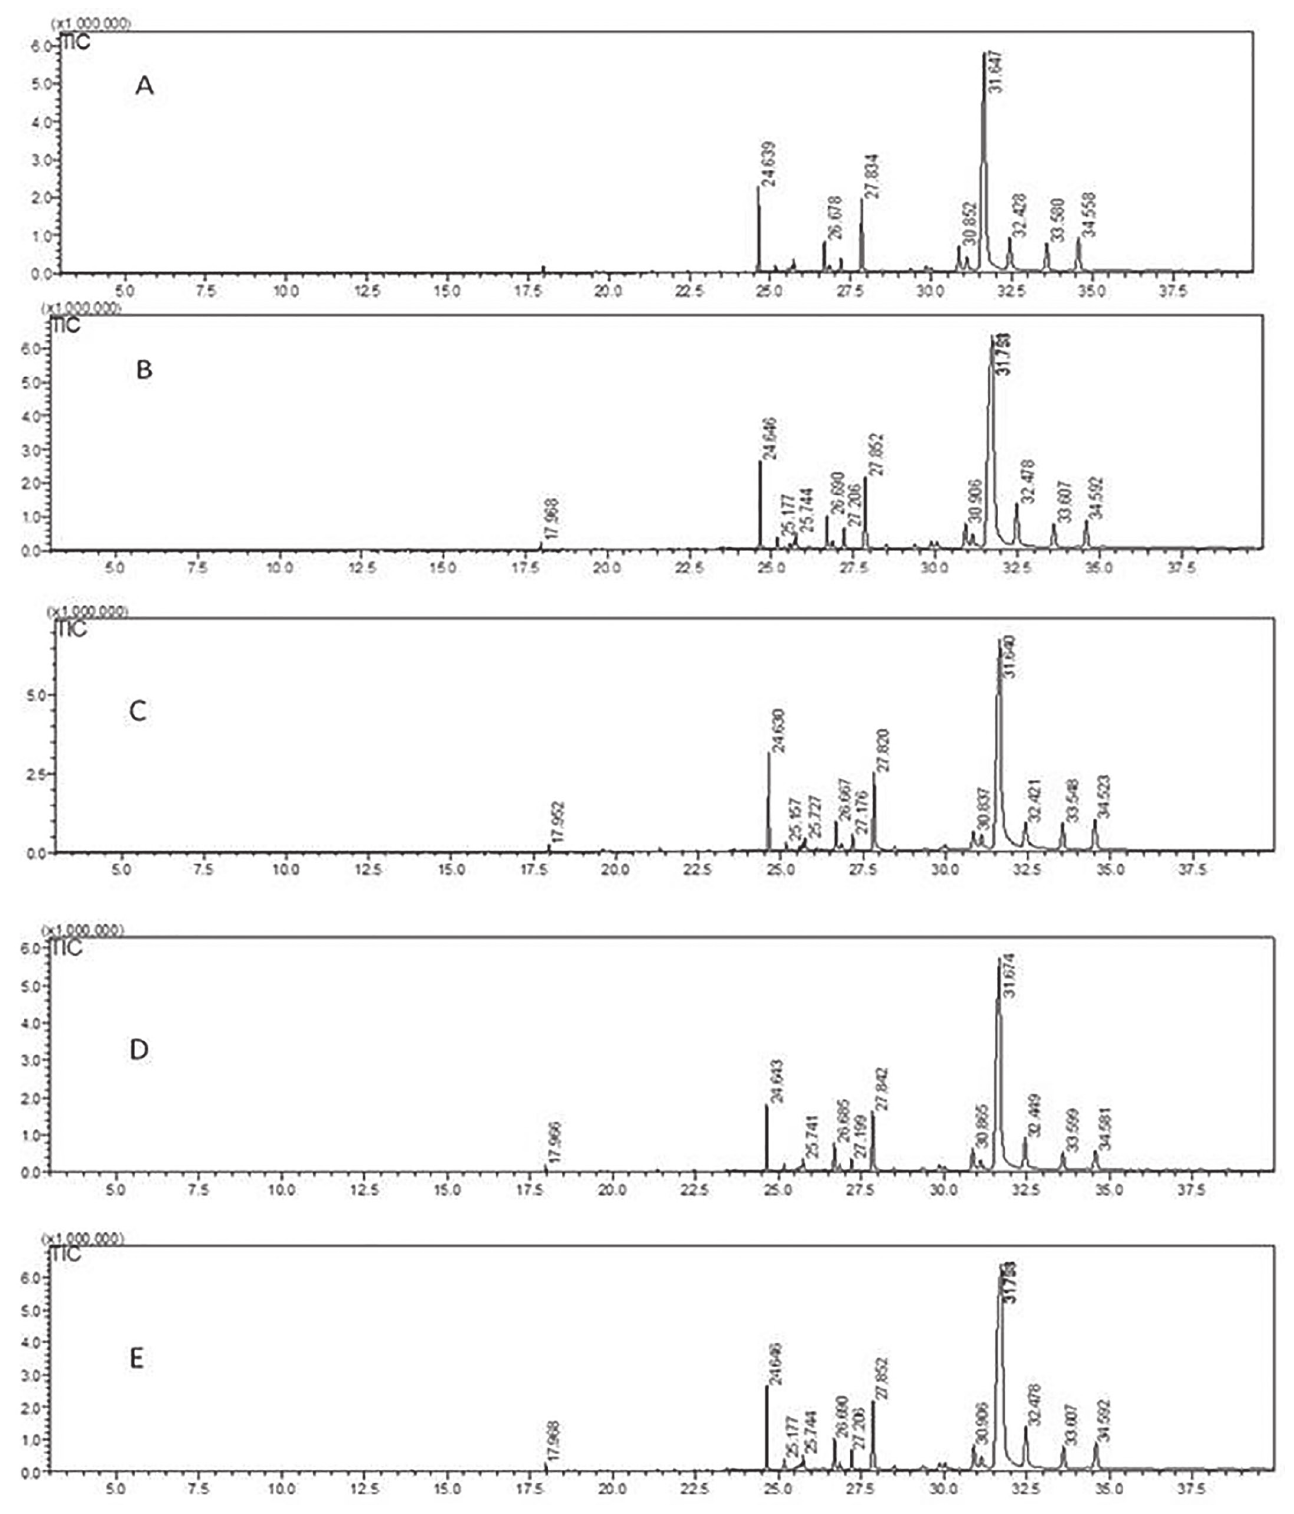
FIGURE 6 - Chromatograms obtained by GC-MS correspondent to the supercritical fluid extracts (SFE) obtained by different temperature and pressure